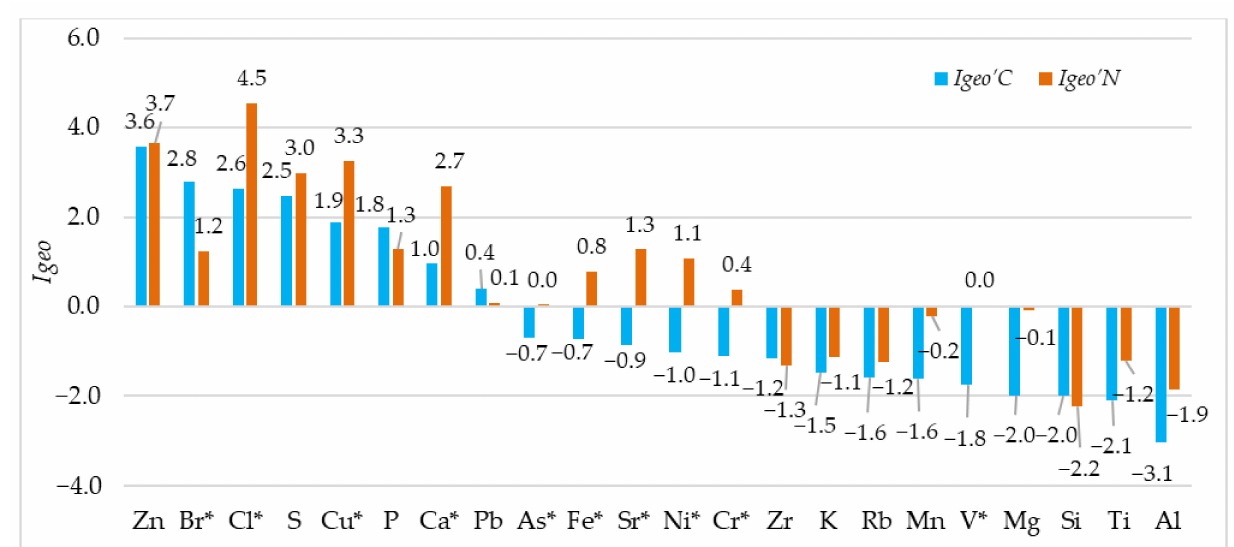
Figure 8. Mean values of Igeo’C and Igeo’N . The analytes are sorted by decreasing Igeo’C values. *—analytes for which so-called contamination classes of alternative indices are different.